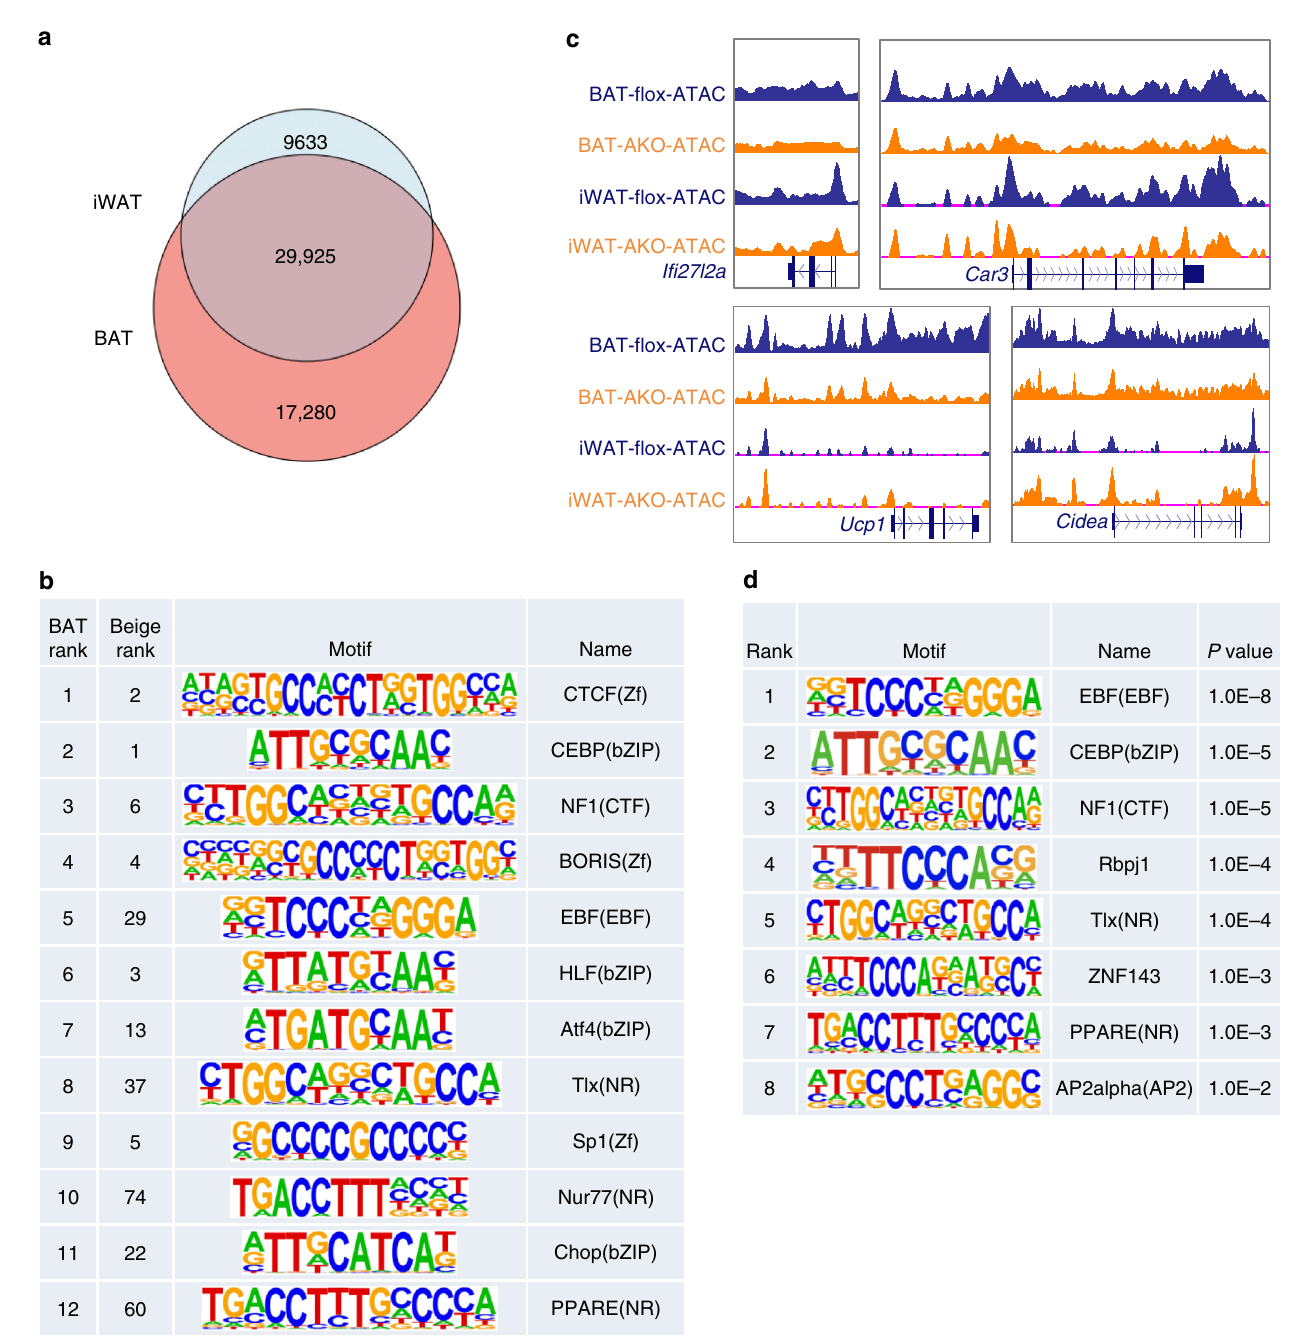
Fig. 5 ATAC-seq analysis of iWAT from cold-acclimated mice. a Overlap of ATAC-seq peaks detected in BAT and cold-acclimated iWAT. b Top 12 motifs enriched in BAT ATAC-seq peaks and their ranks in beige fat. c UCSC genome browser traces of ATAC-seq peaks at the I fi 27l2a , Car3 , Ucp1 , and Cidea loci. d Motif-enrichment analysis of the peaks upregulated in AKO